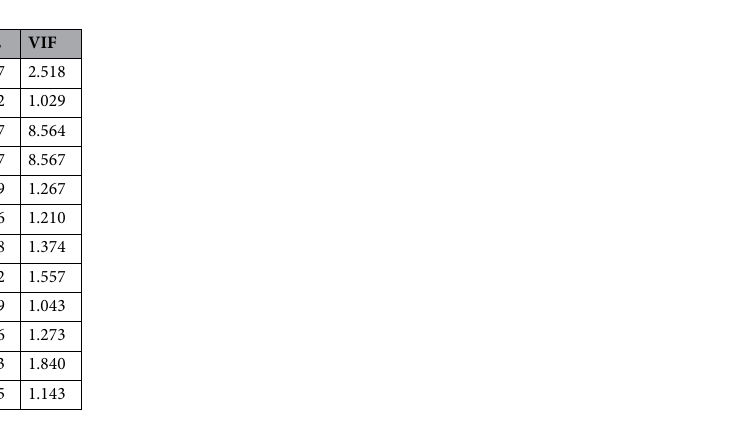
Table 4. Multicollinearity of 12 LSM